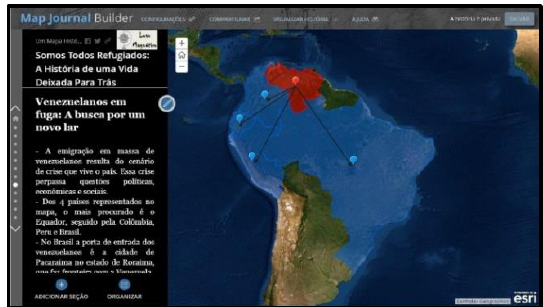
Figure 10. We Are All Refugees: The Story of a Life Left